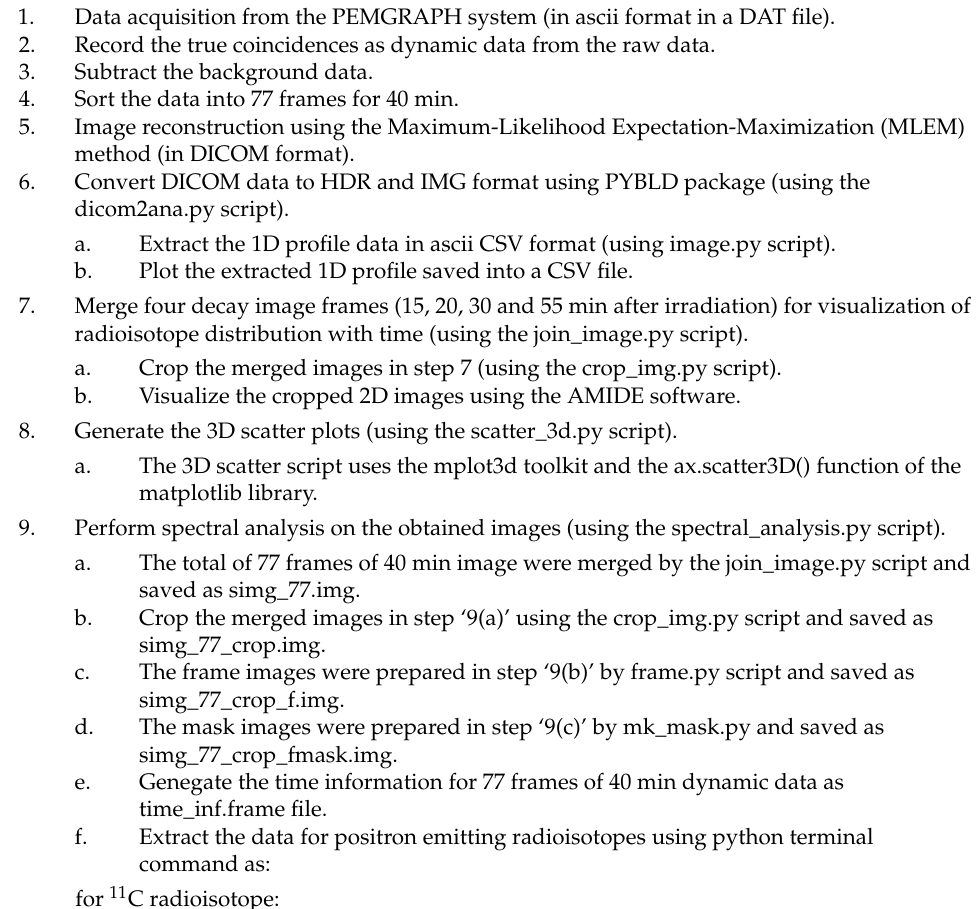
Table 3. The step-by-step algorithm of the analysis scheme for the extraction and 3D visualization of positron emitting radioisotopes using positron emission